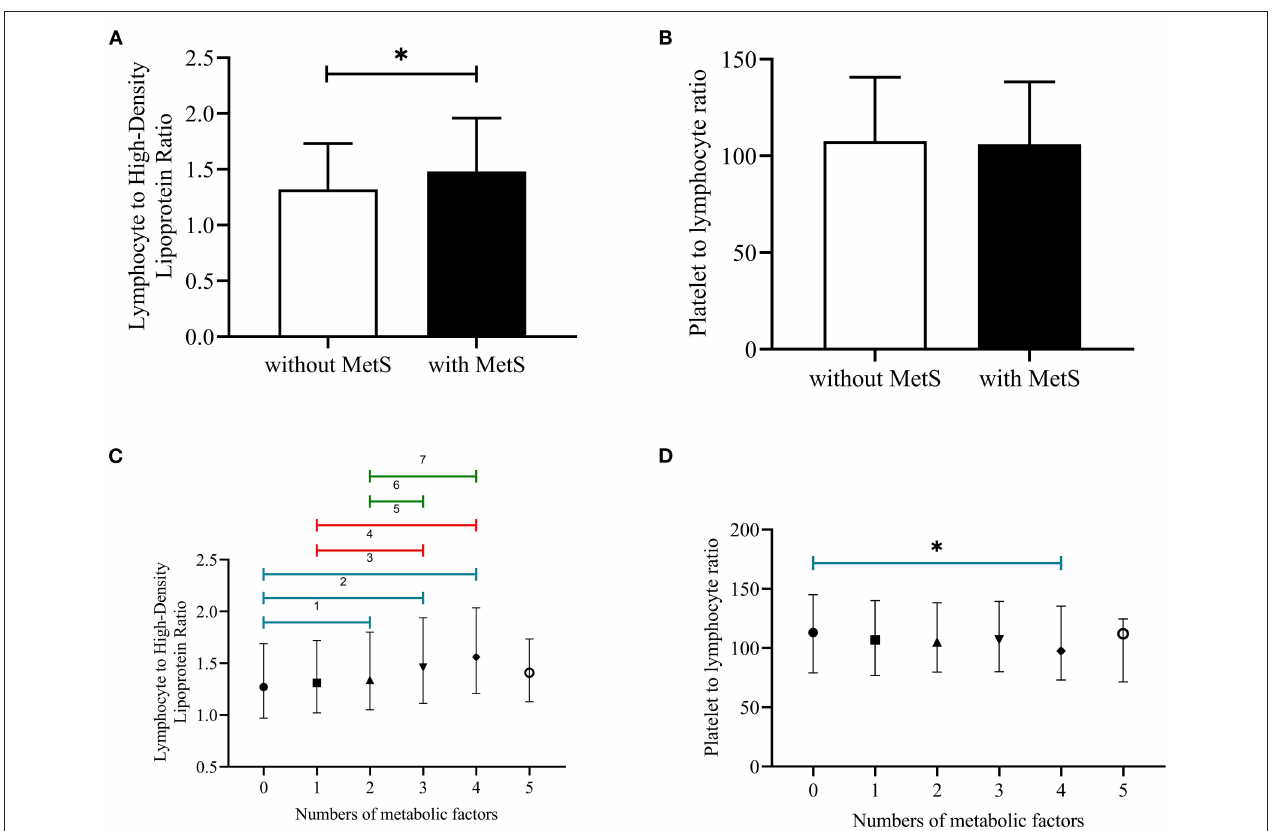
FIGURE 2 | (A–D) Median with interquartile range of LHR and PLR among subjects with or without MetS and different numbers of metabolic disorders. PLR, platelet to lymphocyte ratio; LHR, lymphocyte to high density lipoprotein ratio; 1 P < 0.05, no metabolic factors vs. two metabolic factors; 2 P < 0.05, no metabolic factors vs. three metabolic factors; 3 P < 0.05, no metabolic factors vs. four metabolic factors; 4 P < 0.05, one metabolic factor vs. three metabolic factors; 5 P < 0.05, one metabolic factors vs. four metabolic factors; 6 P < 0.05, two metabolic factors vs. three metabolic factors; 7 P < 0.05, two metabolic factors vs. four metabolic factors; * P < 0.05, no metabolic factor vs. four metabolic